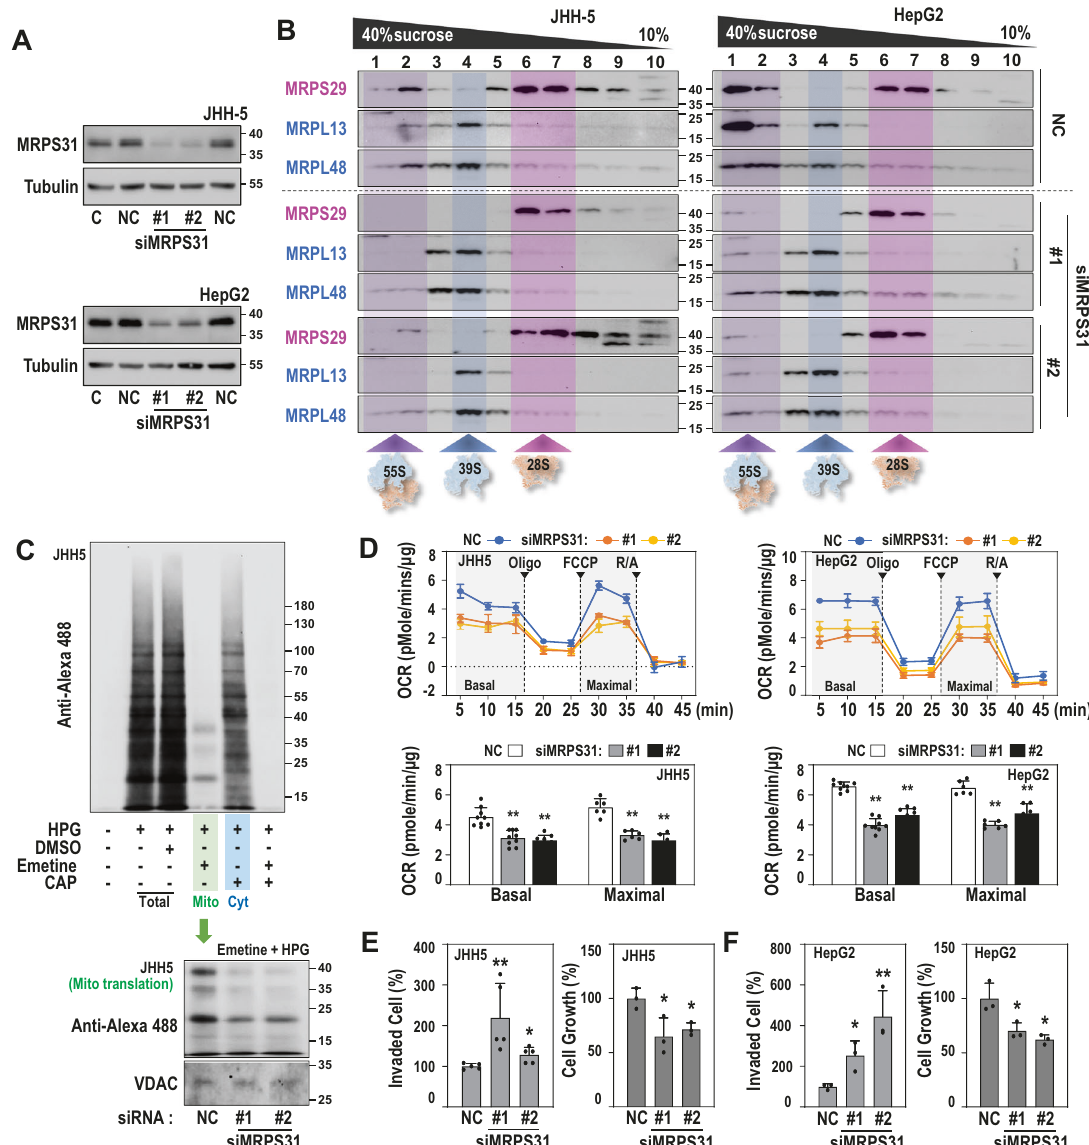
Fig. 5 MRPS31 suppression induces mitoribosomal dysfunction, OXPHOS defect, and cell invasiveness. MRPS31_high type cells (JHH4 and HepG2) were transfected with MRPS31 siRNA for 3 days. A Western blots. B Western blots after sucrose gradient sedimentation analysis of mitoribosome. MRPS29 (a small subunit protein) and MRPL13 and MRPL48 (large subunit proteins) were used as indicators of each subunit. Purple, blue and pink colored box indicated 55 S monosome, 39 S large subunit, and 28 S small subunit, respectively. C Mitochondrial translation activity. De novo synthesized proteins using L-homopropargylglycine (HPG)-conjugated Alexa Fluor 488 were detected by Western blot analysis. To distinguish cytosolic and mitochondrial translation activities, emetine (a cytosolic translation inhibitor) and chloramphenicol (CAP, a mitochondrial translation inhibitor) were used. The effect of MRPS31 knockdown on mitochondrial translation is shown in bottom panel. D Cellular OCR of JHH5 (left) and HepG2 (right) and their quanti fi cations (basal and maximal rates, bottom). Nine independent experiments were performed. ** p < 0.01 vs. siNC by student t test. E, F Cell invasion activity (left, N = 5) and cell growth (right, N = 3) of MRPS31-knockdowned JHH5 (E) and cell invasion activity (left, N = 3) and cell growth (right, N = 3) of MRPS31-knockdowned HepG2 (F) . * p < 0.05 and ** p < 0.01 vs.